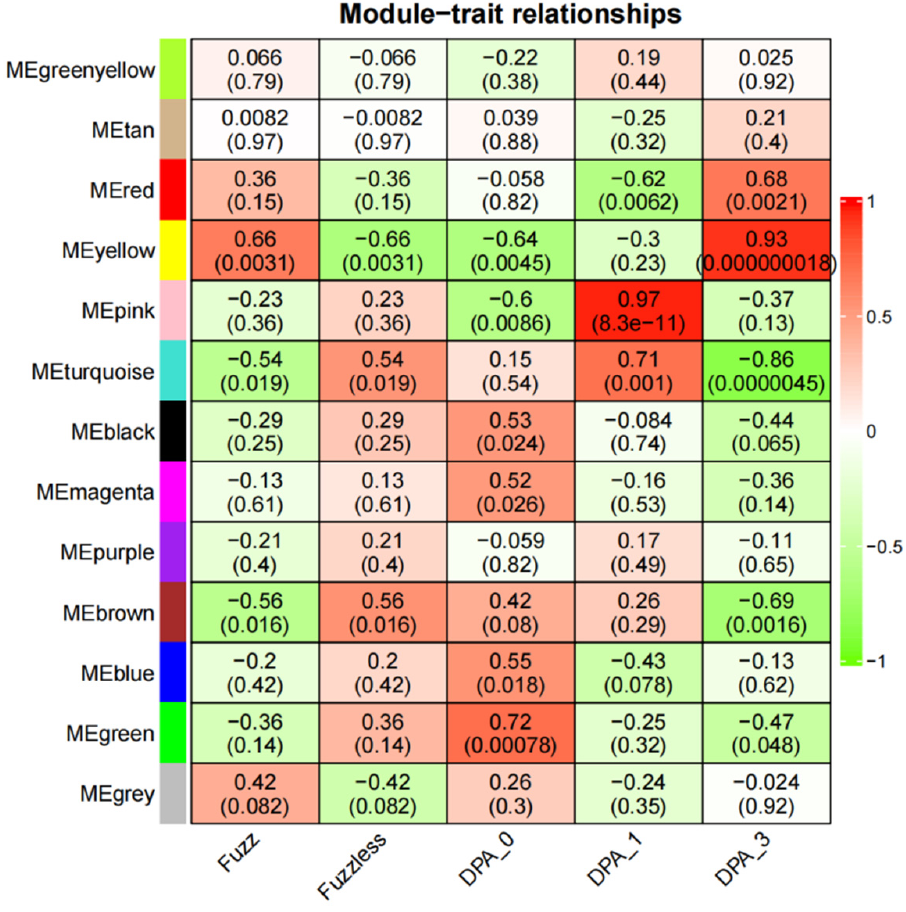
Figure 9. Heatmap of correlation between modules and traits. Numbers in squares represent correlation coefficients and p -values between modules.